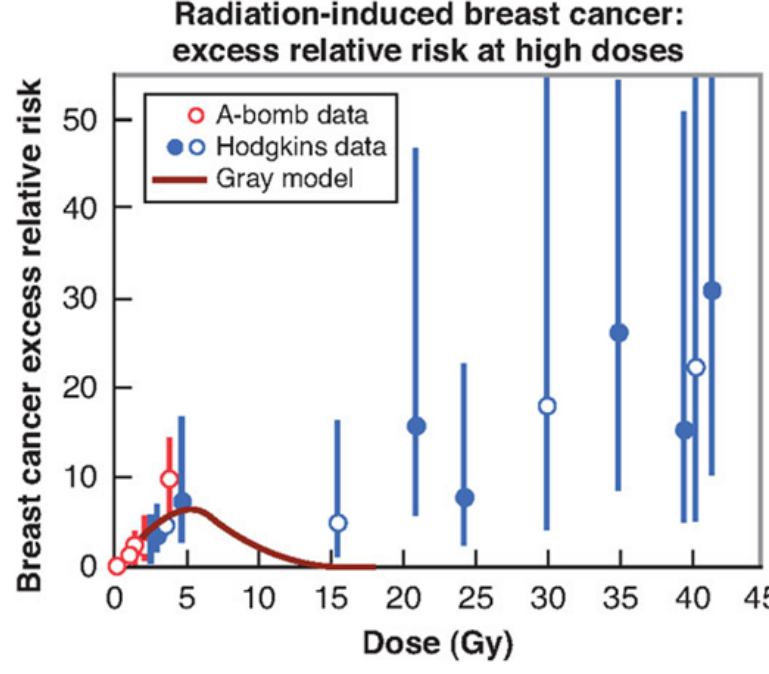
Figure 4. Excess relative risk for radiation-induced breast cancer. The low-dose data points are from A-bomb survivors (<4 Gy). The data points at high doses are from studies of SMN after radiotherapy of Hodgkin disease patient. The excess relative risk does not fall at high doses as predicted by the standard (Gray) model (reproduced with permission from